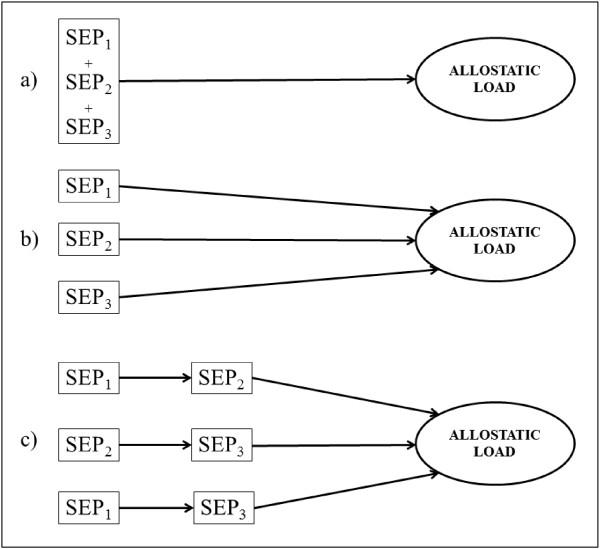
Graphical representation of the different lifecourse models, including the accumulation model (a), the critical periods model (b) and the social mobility model (c).